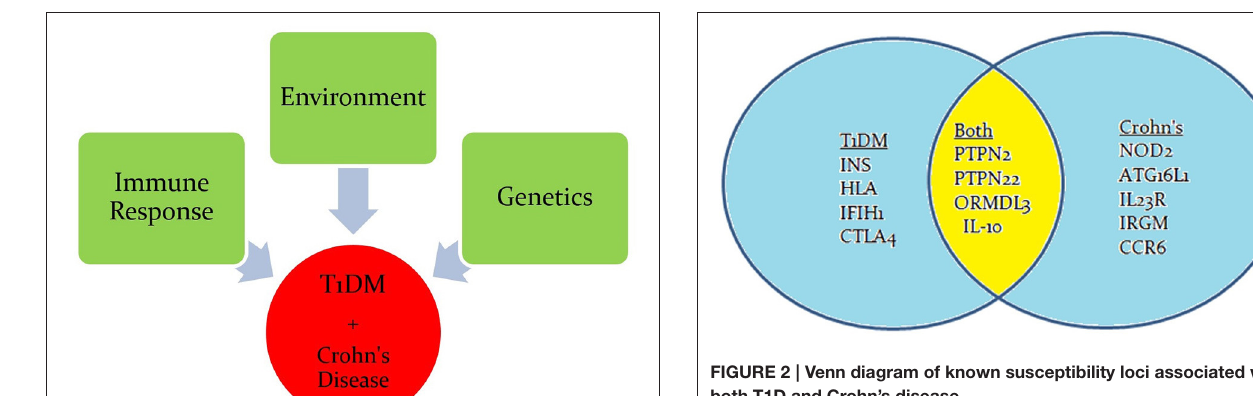
others (Nazareth et al., 2015). Naser et al. has shown that